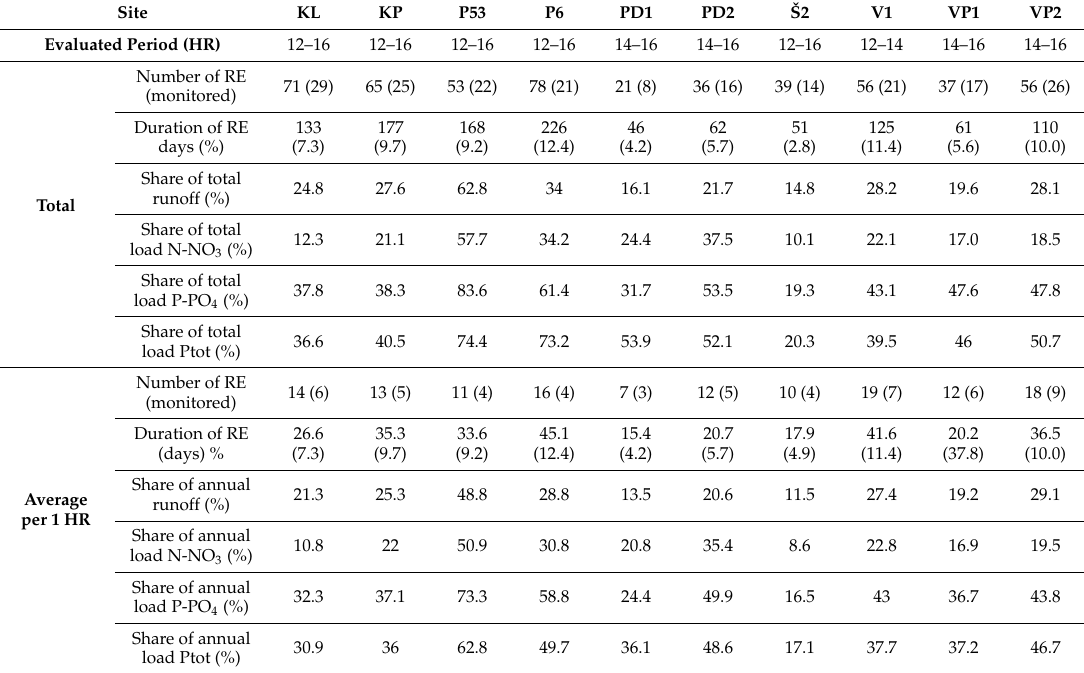
Table 3. The share of runoff events in the total annual drainage runoff and in N-NO 3 , P-PO 4 , and P tot total annual loads and the share of runoff events on average within one HR for the monitored hydrological years at all the